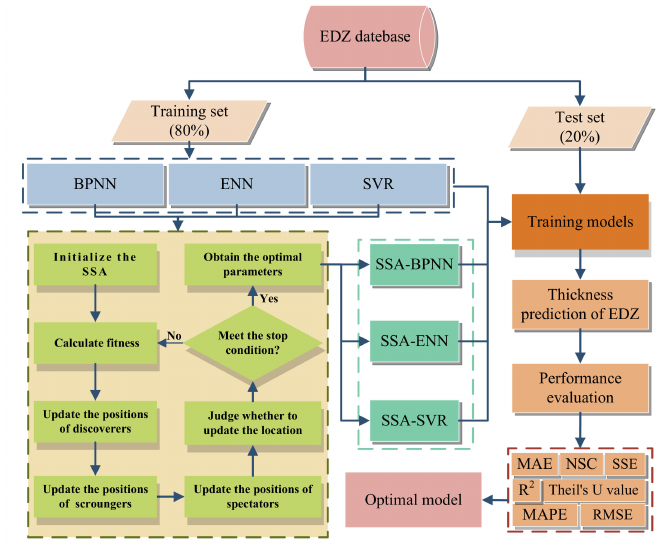
Figure 4. Structure of the proposed